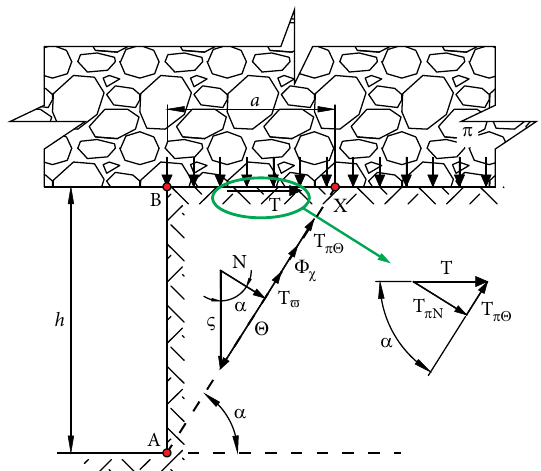
Fig. 2. Scheme for landslide